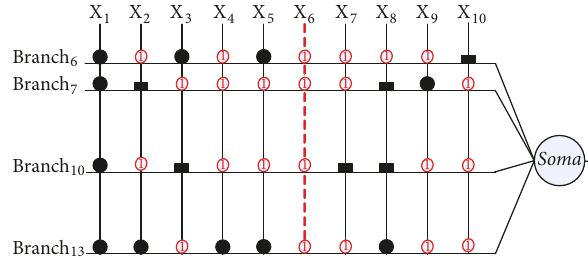
Figure 14: The dendritic morphology of the Distress data set after synaptic pruning.